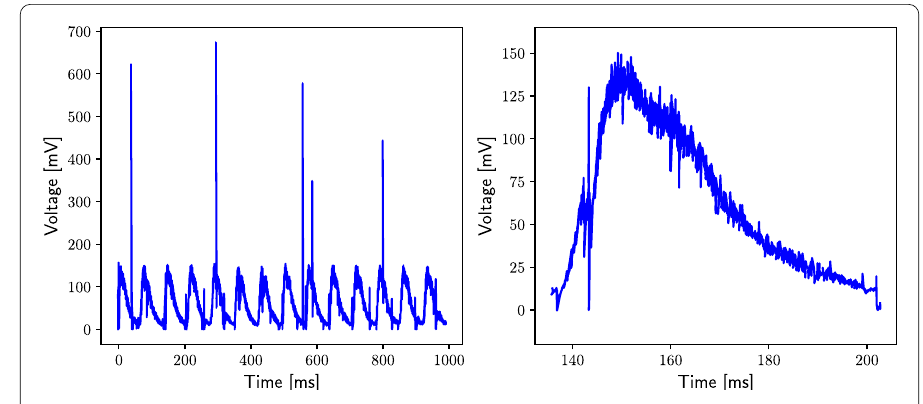
Figure 6 Raw signal from the I-BM for a chopper setting producing a white pulse. The ADC values are stored every 800 ns. The x-axis shows the time evolution, the y-axis shows the voltage created from the change of the neutron flux in time. Left: the first 100 ms, right: zoom of third pulse